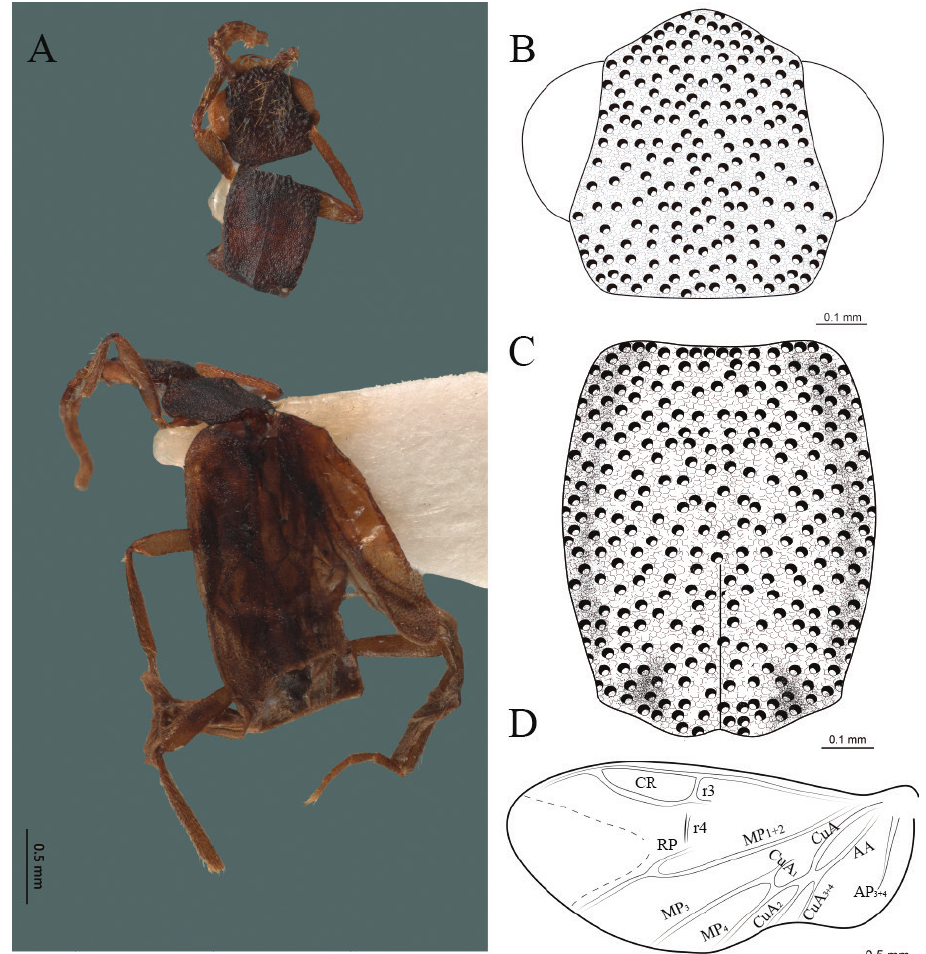
Figure 30. Cenophengus villae Zaragoza-Caballero, 1984, male. Habitus: A dorsal B head dorsal C pro- notum dorsal D hind wing. Wing venation: CR = Radial Cell; r3 = radial 3 vein; r4 = radial 4 vein; RP = Posterior Radial vein; MP1+2 = Posterior Median vein; CuA = Cubital vein; AA and AP = Anterior and Posterior Anal